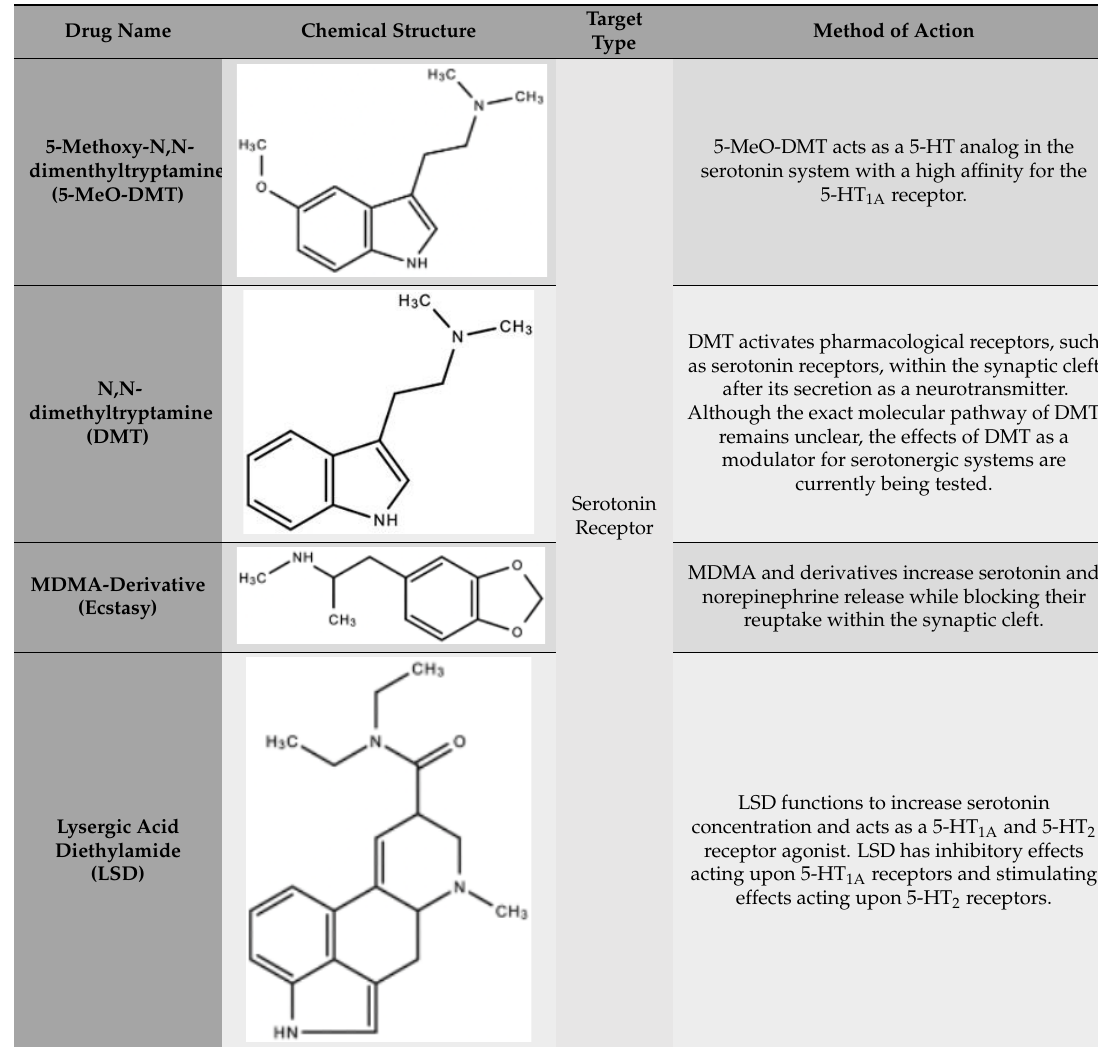
Table 1. Biochemical structures, mechanisms, and receptor functions of twenty psychoceutical drugs.